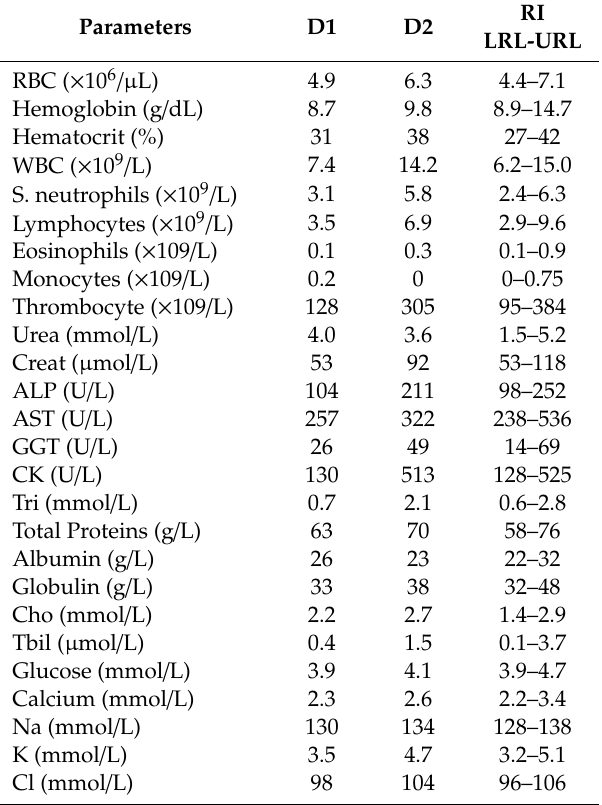
Table 2. Complete blood count and serum biochemistry profile of two burned donkeys